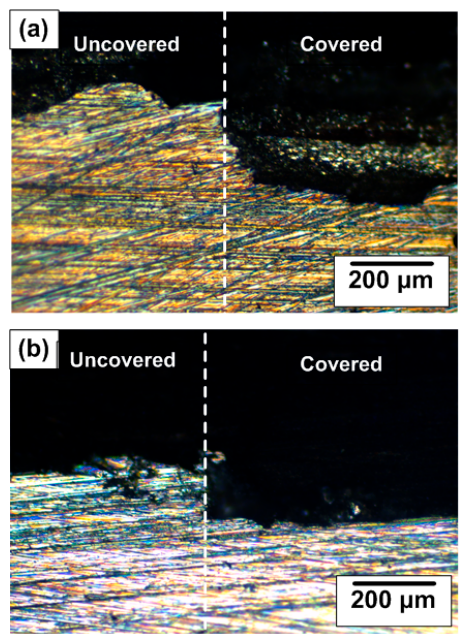
Figure 10. Cross-sectional images of the boundary of covered and uncovered ( a ) α -FeOOH, ( b ) Fe 3 O 4 iron oxides deposit , after potentiostatic tests under − 650 mV SCE for 20 h in the simulated district heating water at 40 °C. Metals 2017 , 7 , 182